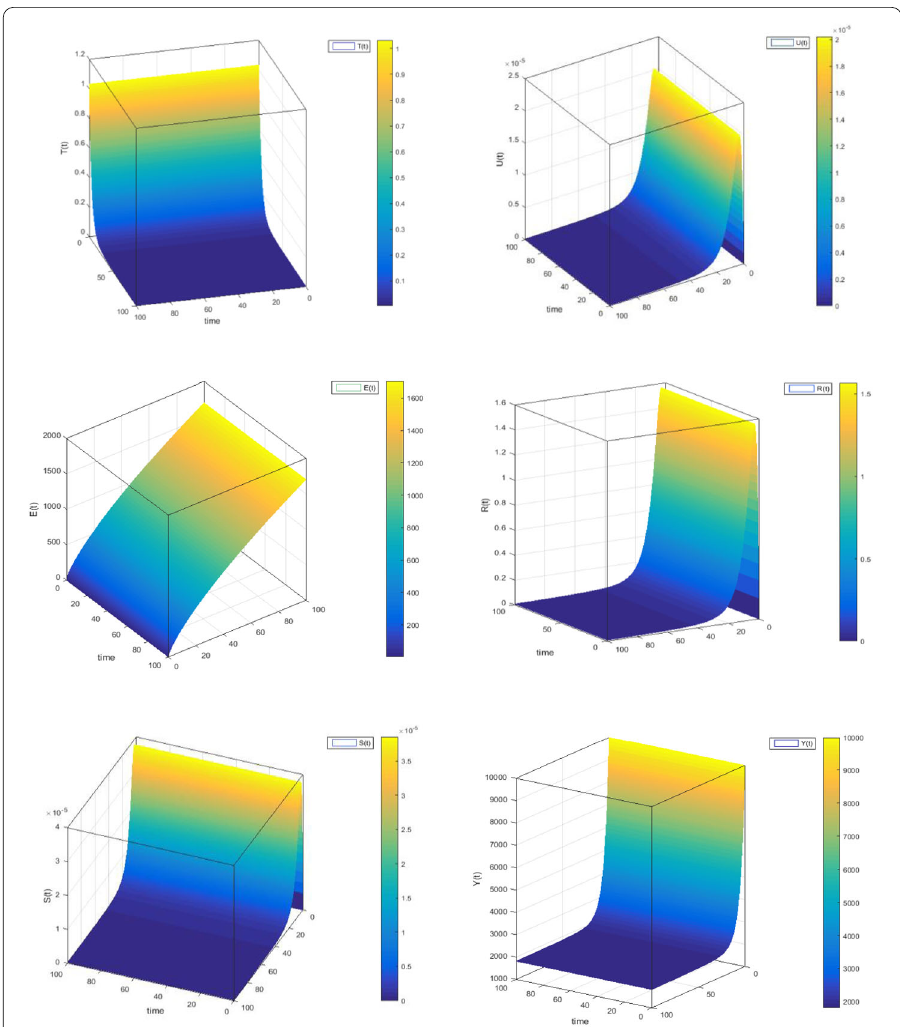
Figure 2 Numerical simulations of the state variables with controls cases at α = 0.96 using